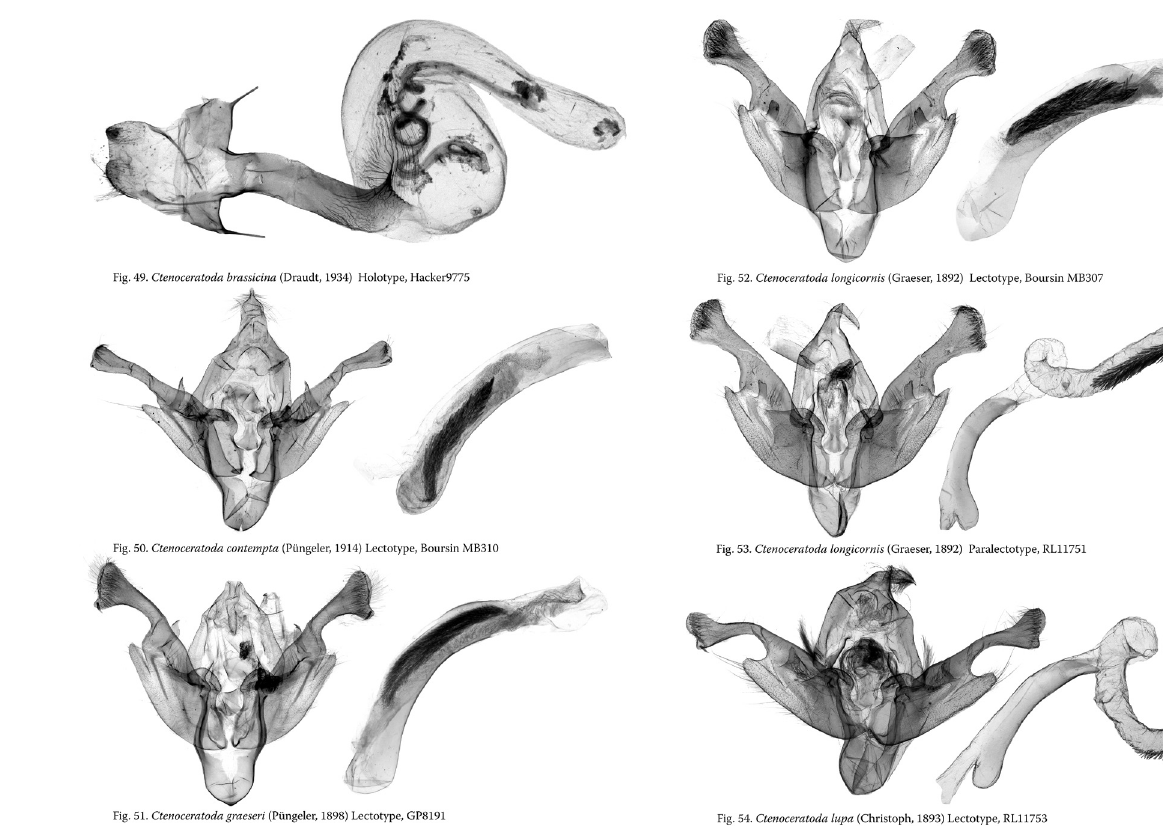
Figure 49–51. 49. Ctenoceratoda brassicina (Draudt, 1934) Holotype female. 50. Ctenoceratoda contempta (Püngeler, 1914) Lectotype male. 51. Ctenoceratoda graeseri (Püngeler, 1898) Lectotype male.